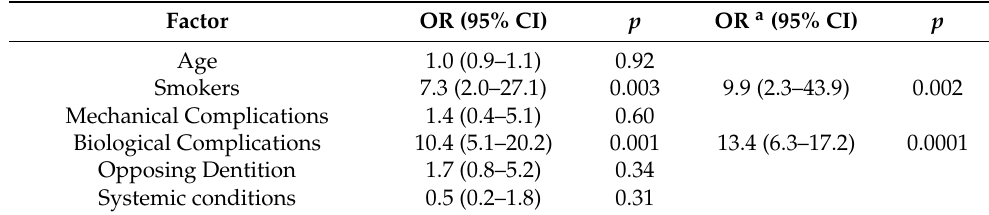
Table 3. Risk indicators for marginal bone loss > 3.0 mm (OR stands for Odds Ratio, while CI stands for Confidence Interval, p < 0.05 was considered statistically significant, we replicate the test for significant results “a”).